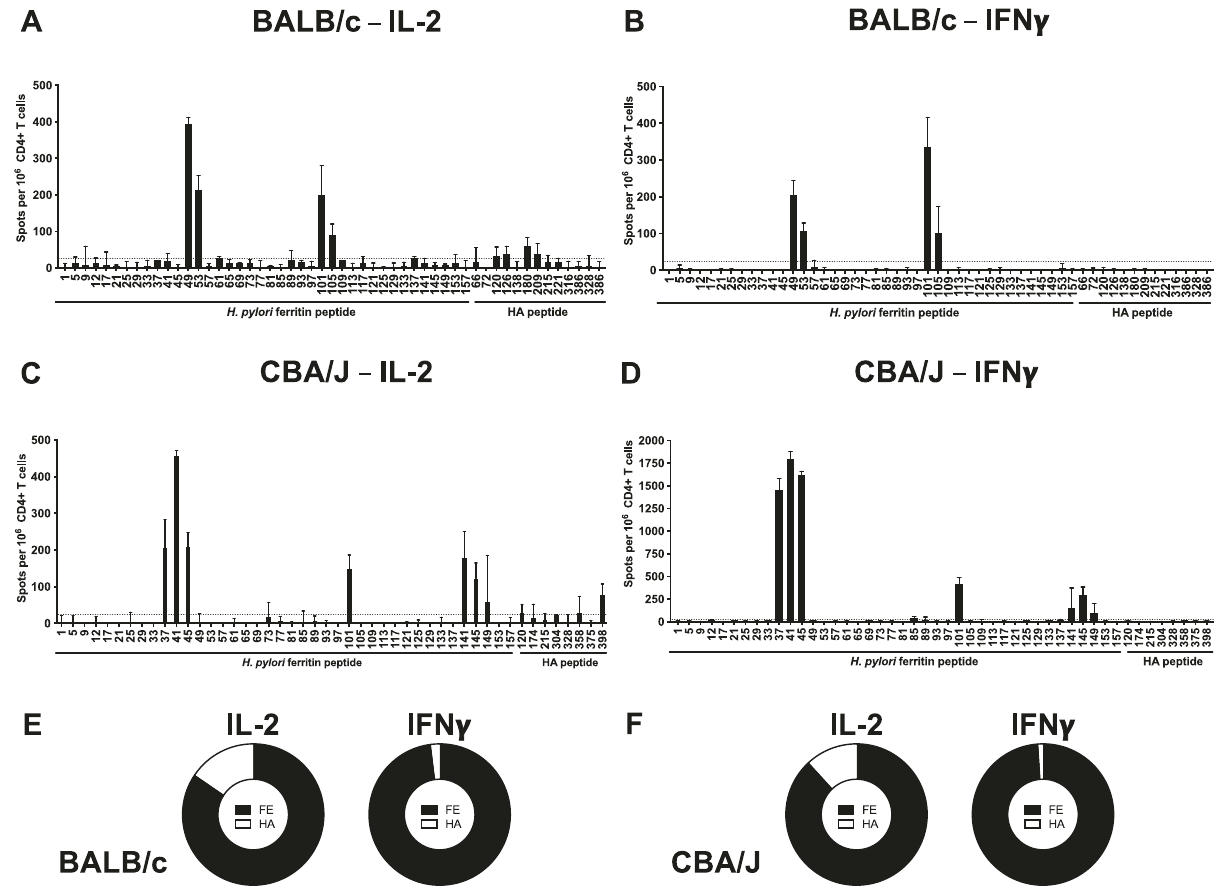
Fig. 1 De fi ning immunodominance of the CD4 T cell repertoire in BALB/c and CBA/J mice expressing diverse I-A and I-E alleles. Identi fi cation of immunodominant ferritin epitopes was performed by IL-2 and IFN γ cytokine ELISpot following immunization with full length HA-ferritin nanoparticles. Puri fi ed CD4 T cells were restimulated with peptides spanning the sequence of H. pylori ferritin and major HA peptides. Experiments were conducted in A , B BALB/C mice (MHC II I-A d /E d ) and C , D CBA mice (MHC II I-A k /E k ). The fraction of the cytokine- producing CD4 T cell response speci fi c for ferritin (black) or HA (white) is shown for E BALB/c and F CBA/J mice, respectively. Data are shown as the mean and SD of two independent experiments of fi ve pooled mice per